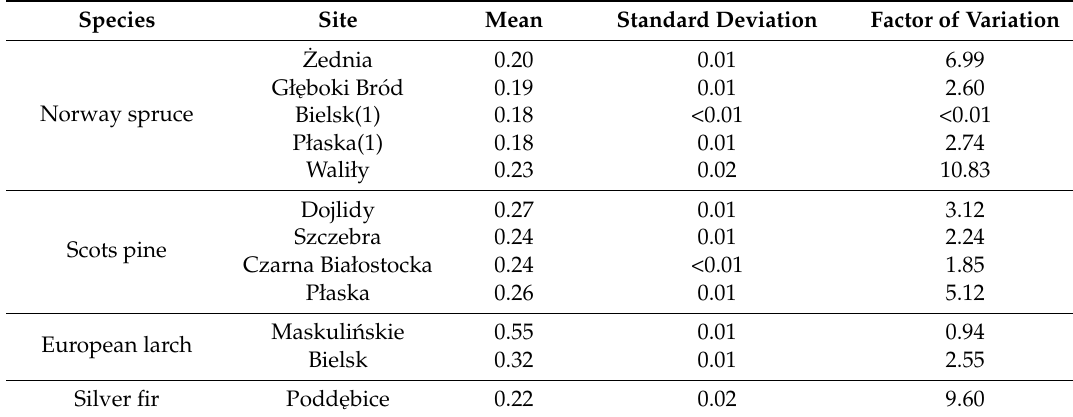
Table 6. Conversion factors for the studied cone